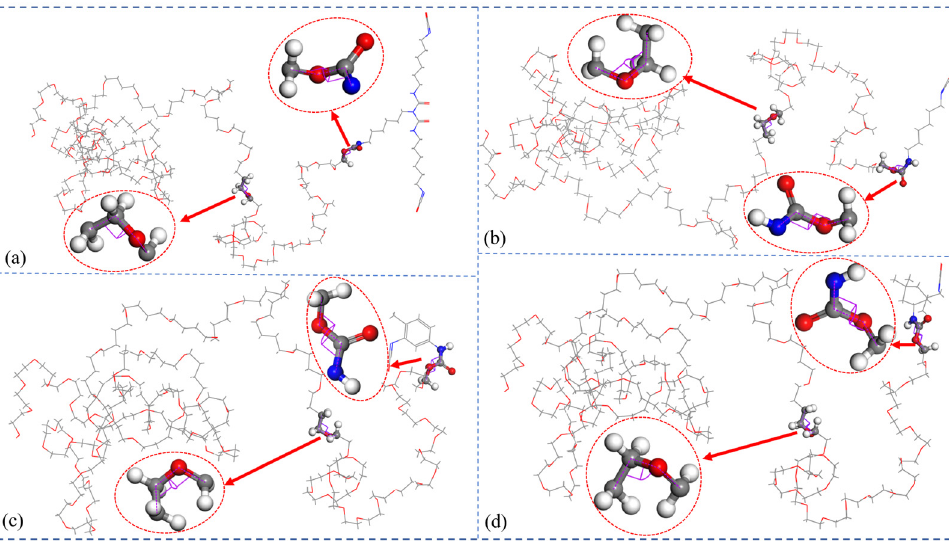
Figure 6. The torsion of rotation of two specific bonds Φ 1 and Φ 2 in four HTPE polyurethanebinders.